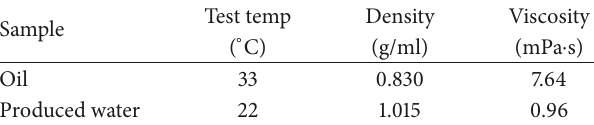
Table 1: Density and viscosity of oil and produced water.